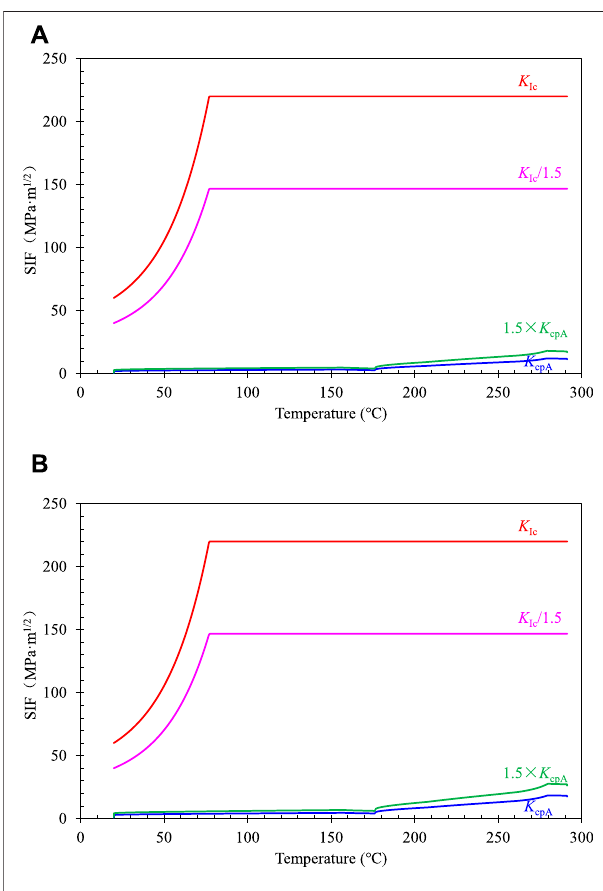
FIGURE 11 | Stress intensity factors of embedded crack under TR1-1 condition: (A) a (cid:3) 10.057 mm, c (cid:3) 30.004 mm; (B) a (cid:3) 20.0 mm, c (cid:3) 200.0